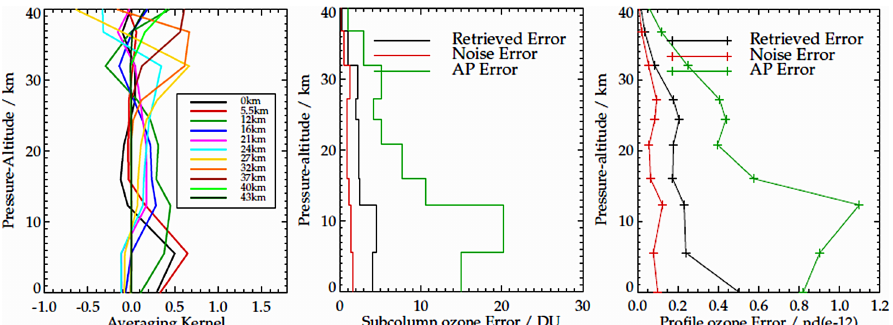
Figure 2. The left panel shows averaging kernels derived in number density units on levels for a nadir pixel at 45 ◦ N on 25 August 2008. The averaging kernels themselves are unitless but the magnitude and shape of the off-diagonal elements are very different when evaluated in either VMR or number density. The centre panel shows the associated ESD, noise-only and a priori subcolumn errors, and the panel on the right the errors for the profile.